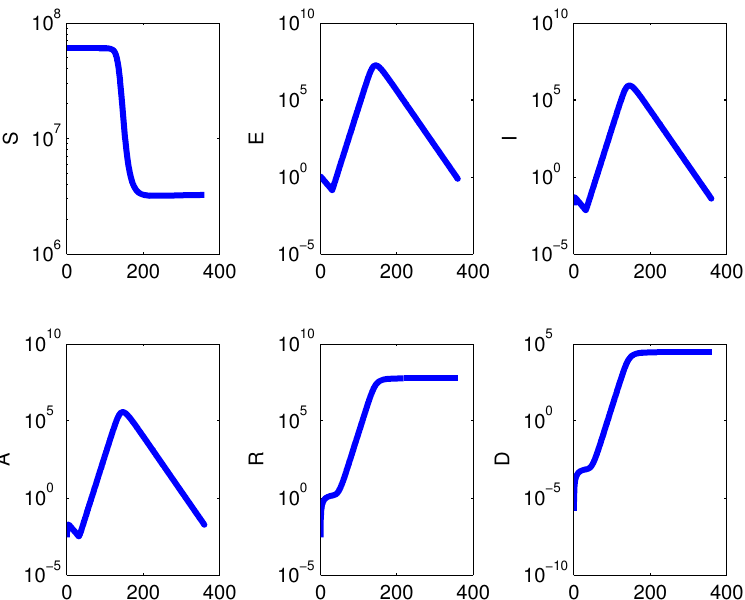
Figure 7. On a semilogarithmic scale, the total populations with the lock-down policy, implemented from time 1 up to time 30, with the milder reduced contact rate β I = 10 − 8 , after which β I = 10 − 7 resumes. The simulation runs over a one year timespan for the simplified model (1). Left to right and top to bottom, the subpopulations are: S , E , I , A , R and D , the disease-related deceased